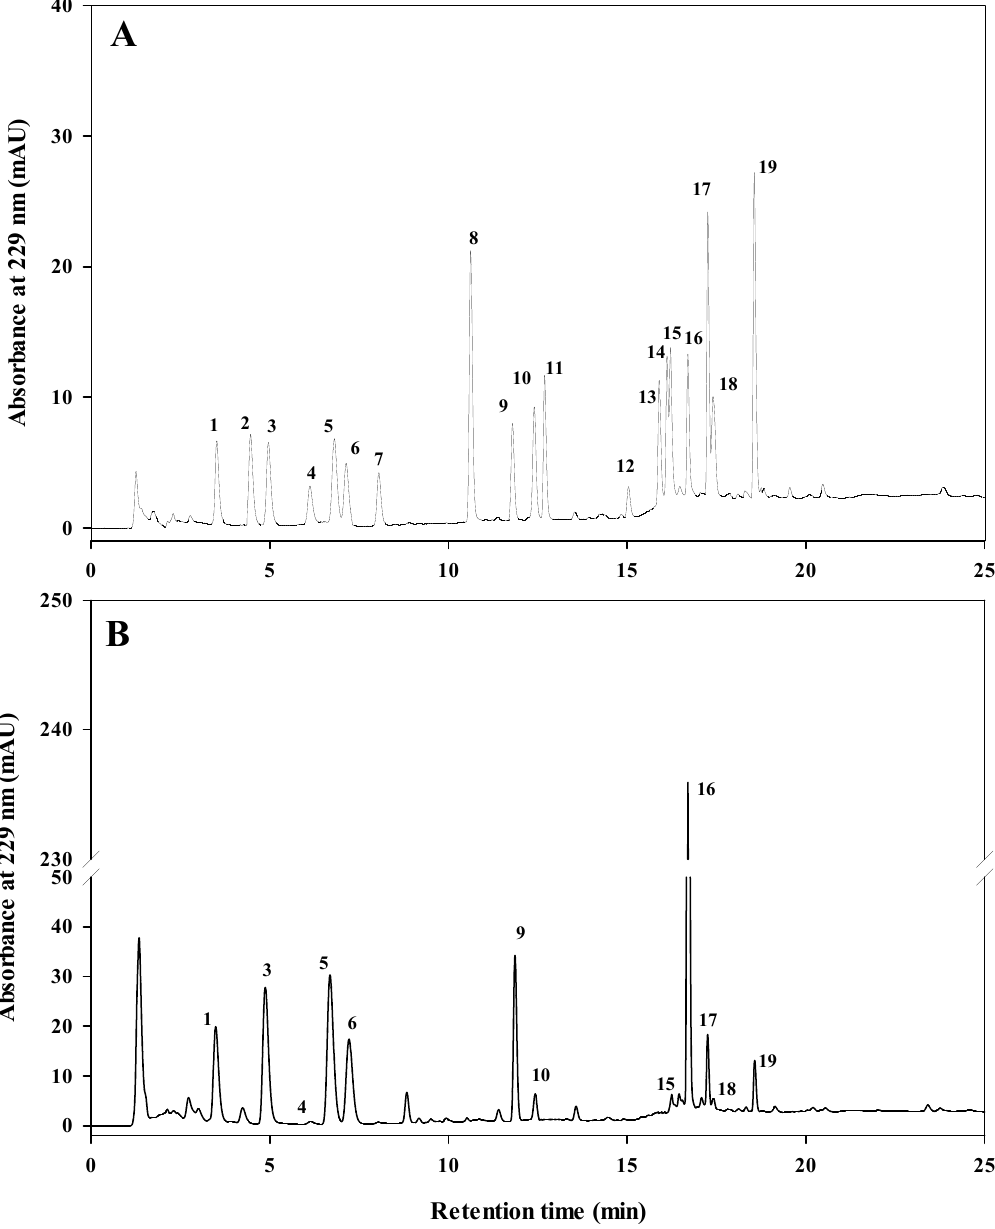
Figure 1. High performance liquid chromatography (HPLC) chromatogram of desulfo- glucosinolates (GSLs) in standard mixture ( A ) and cabbage sample ( B ). Refer to table 1 for peak